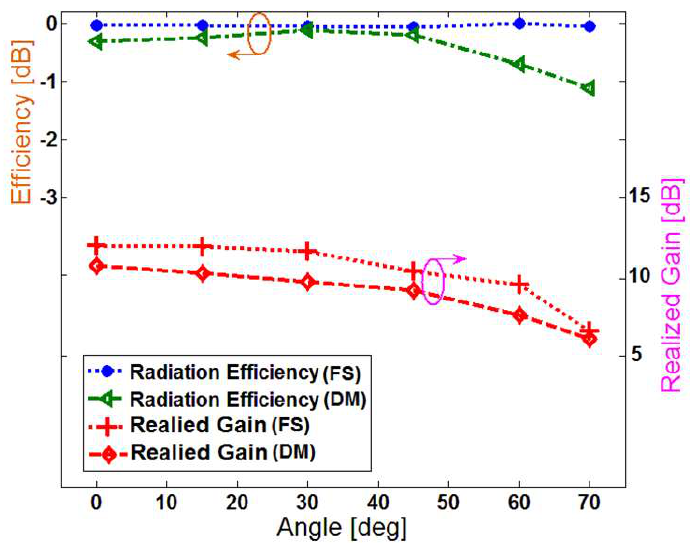
Figure 23. Comparison between the characteristics of the array in FS and DM.